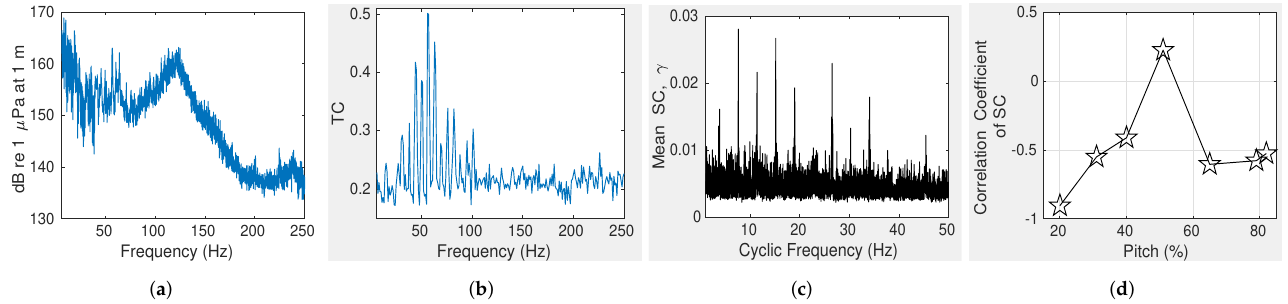
Figure 13. The ( a ) power spectral density (PSD), ( b ) temporal coherence TC , and ( c ) mean spectral coherence (SC) γ ( α ) distributions of ship-radiated underwater sound when the ship changed both propeller RPM and pitch ratios. ( d ) The correlation coefficients between the mean spectral coherence values in ( c ) and those at different pitch ratios in Figure 9, with respect to the first four harmonics of shaft frequency SF